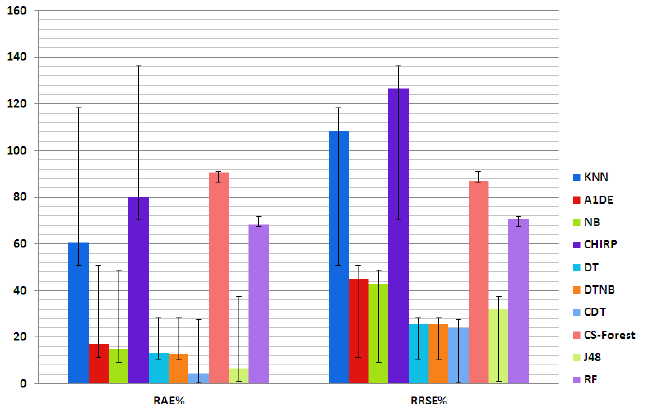
Figure 4. RAE% and RRSE% analysis of individual techniques along with SD Bar.